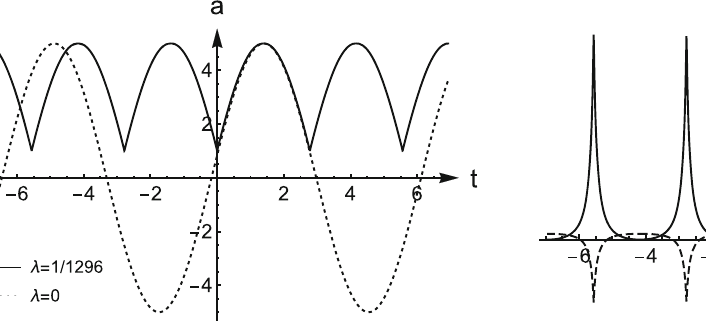
solution of a when λ = 0. In the right ρ and p of the solid a solution are presented and it is easy to see that ρ + p >